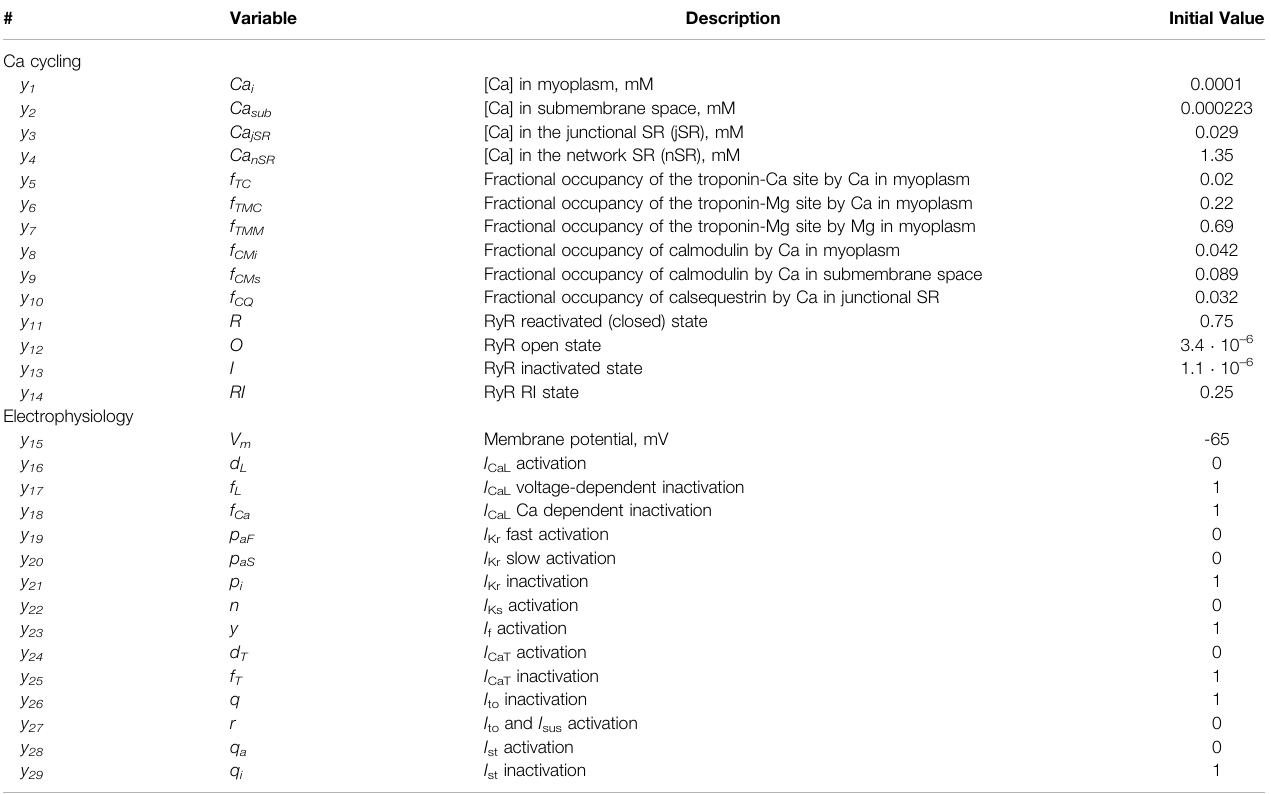
TABLE 2 | State variables y 1 -y 29 with their descriptions and initial values assigned to all cells in our SAN tissue model simulations.